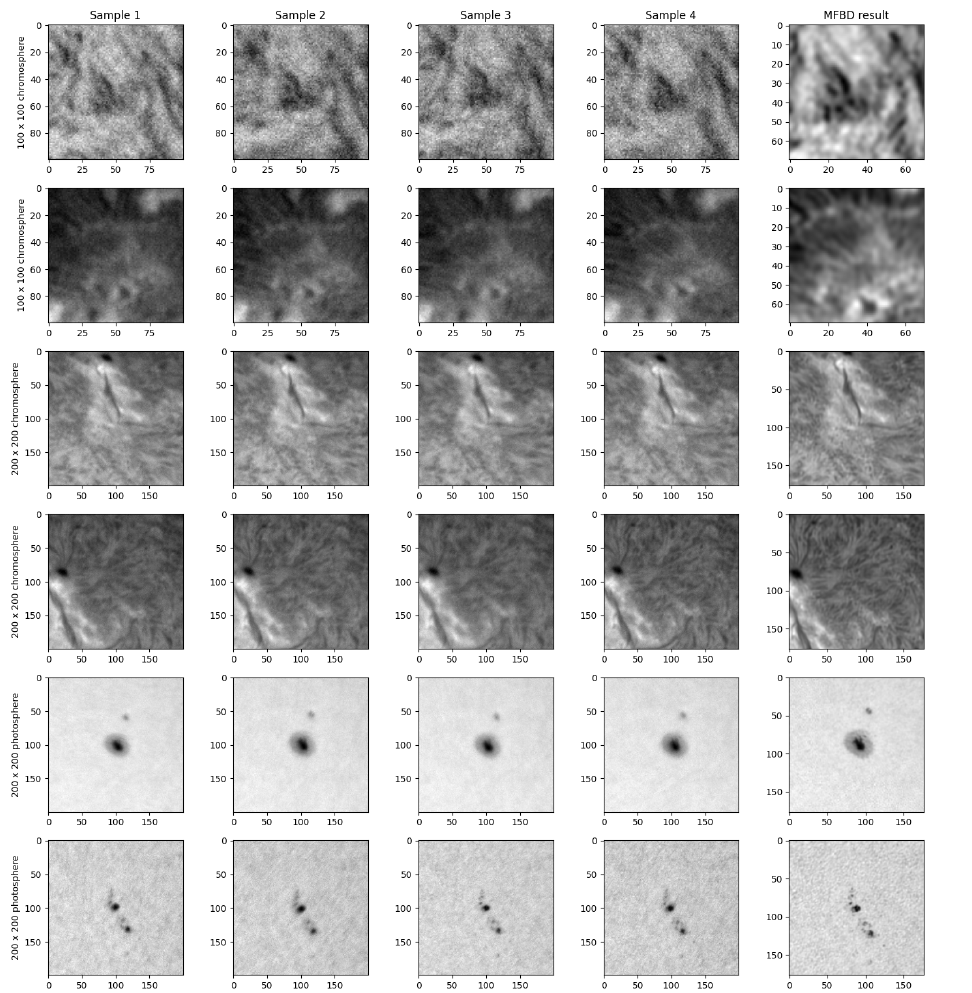
Figure 8. Sample results from MFBD processing together with the first 4 samples of image series. Data from 100 × 100- and 200 × 200-pixel formats, for both chromosphere and